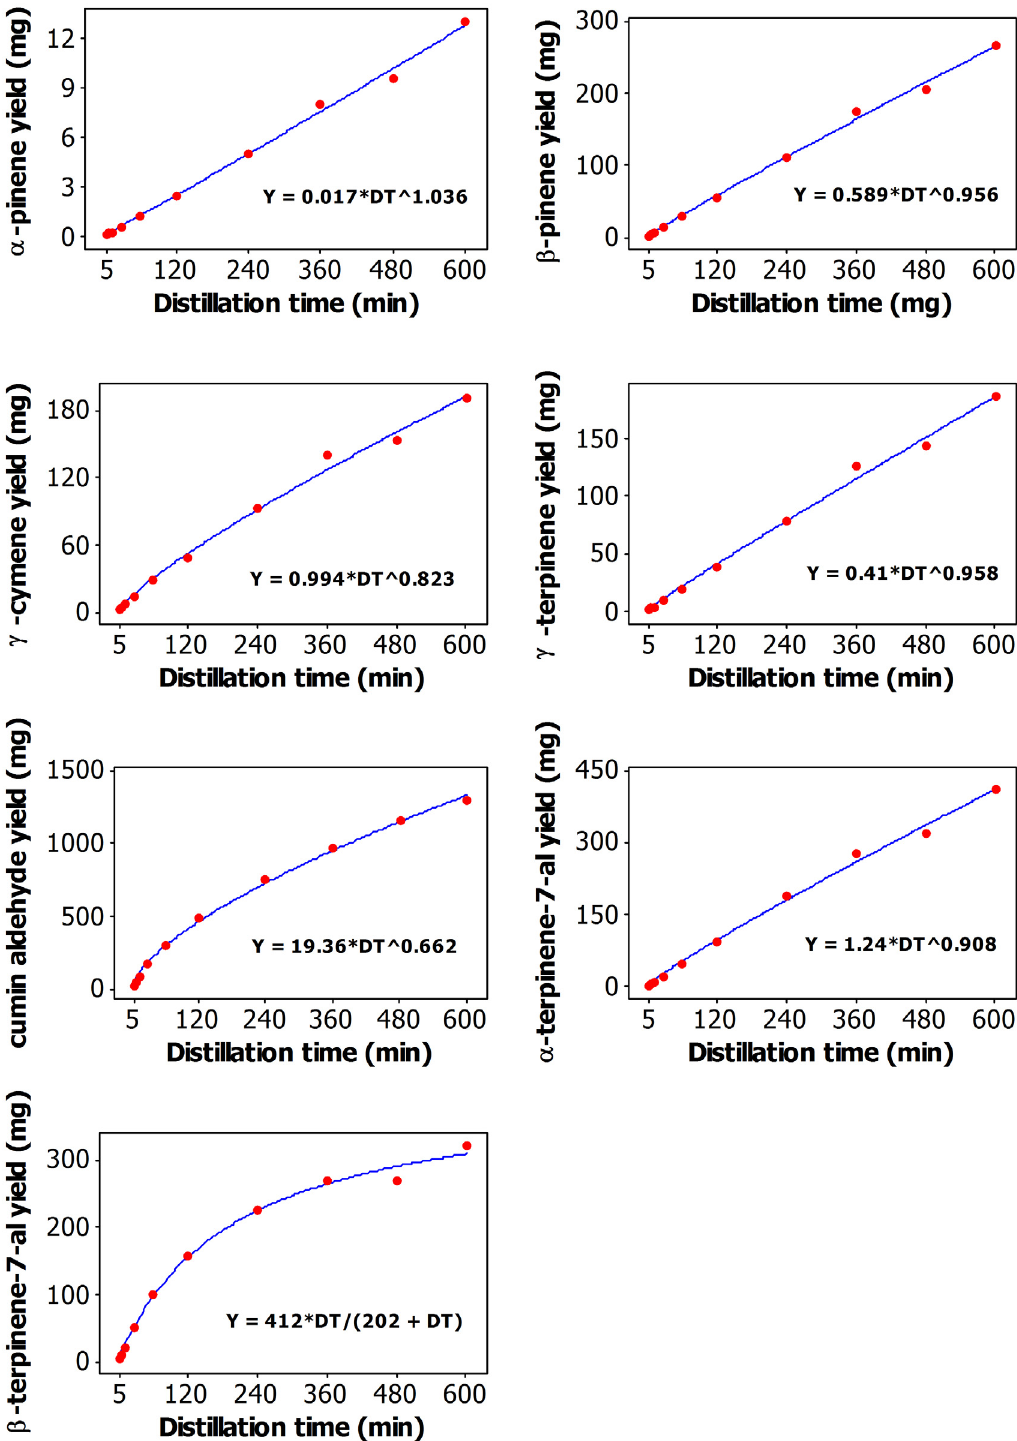
Fig 3. Plot of Distillation time vs yield (mg/100 seed) of α -pinene, β -pinene, γ -cymene, γ -terpinene, cumin aldehyde, α -terpinen-7-al, and β - terpinen-7-al along with the fitted (solid line) Power and Michaelis-Menten models.